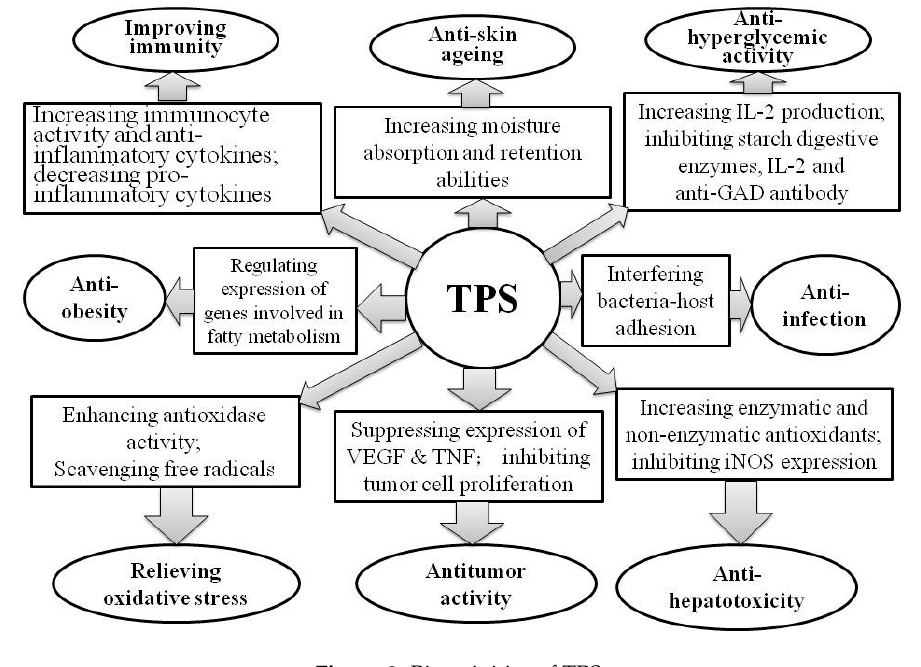
Figure 2. Bioactivities of TPS.